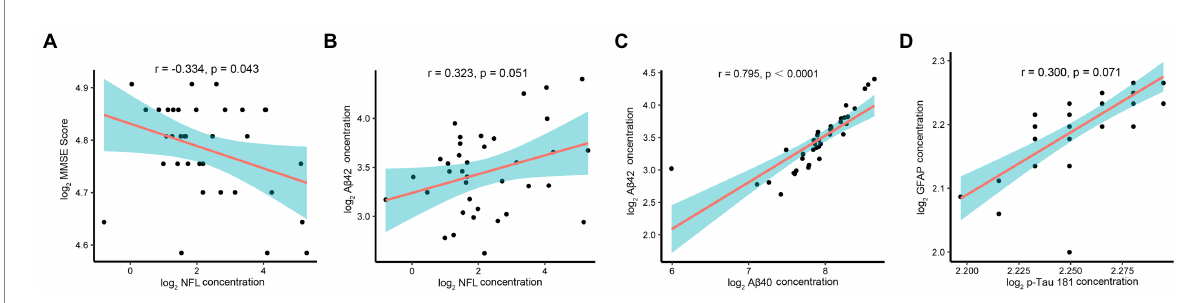
FIGURE 2 Correlation analysis, AD-related biomarkers and MMSE scores in nAMD group. Note: The AD-related biomarkers concentrations and MMSE scores were log-transformed. p < 0.05 was considered statistically significant. The blue area represented the 95% confidence interval. (A) Lower MMSE scores correlated with higher AH levels of NfL ( r = − 0.334, p = 0.043). (B) Although it has not reached statistical significance, there was a correlation between the levels of NfL and A β 42 ( r = 0.323, p = 0.051). (C) Higher levels of A β 40 in AH were associated with higher levels of A β 42 ( r = 0.795,